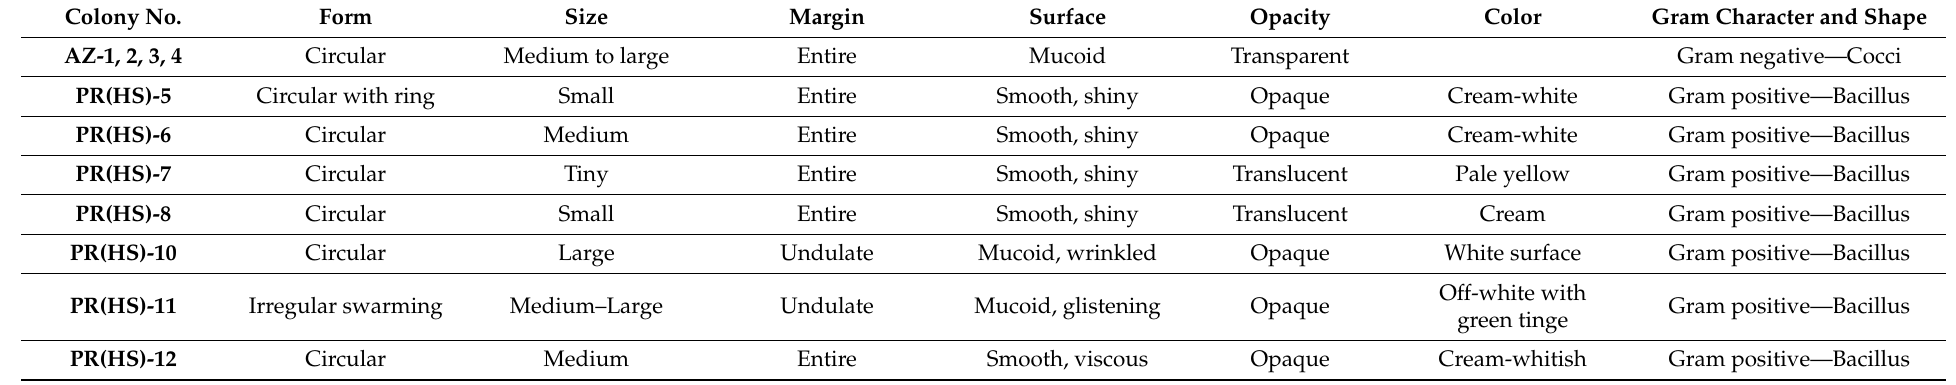
Table 1. Morphological studies and Gram staining of bacterial